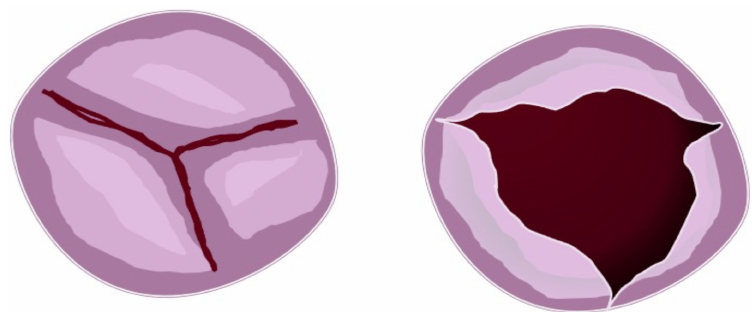
Figure 3. Partial fusion aortic valve. Figure represents three cusps with partial leaflets fusion seen in the short heart axis ( left ). In this case, the opened ( right ) aortic valve is similar to the normal valve but with a more narrow area.